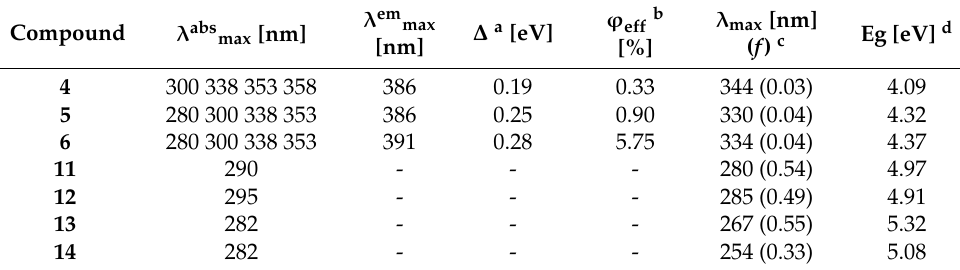
Table 1. Spectroscopic properties of the studied derivatives determined for acetonitrile solutions.